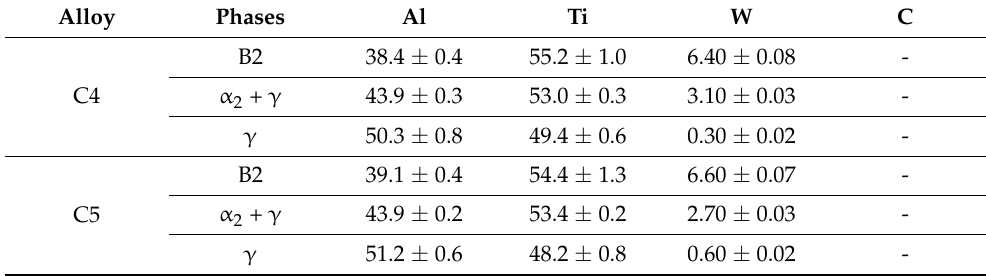
Table 2. Chemical composition of individual regions in the as-cast C4, C5, C8, C12, and C20